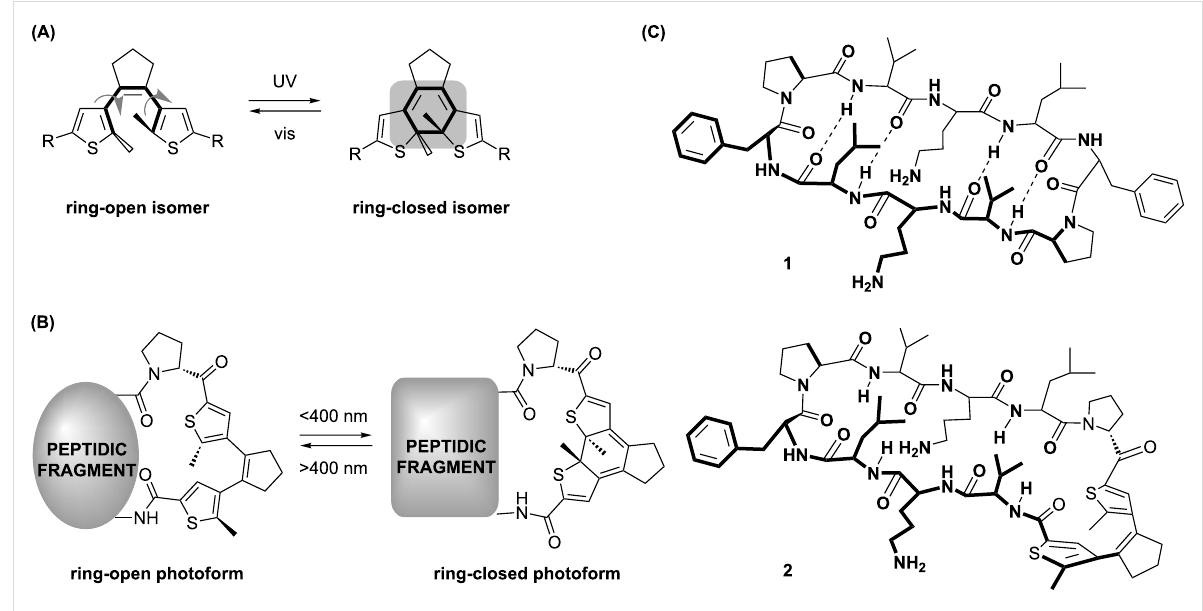
Figure 1: DAE photoswitch and photoswitchable peptides explored in this study. (A) The reversible photoisomerization of the dithienylethene photo- switch core. (B) Photoconversion between ring-open and ring-closed photoforms of DAE-derived peptides. (C) Structures of the non-photoswitchable cytotoxic peptide GS ( 1 ), and one of our first photoswitchable prototypes 2 in the ring-open